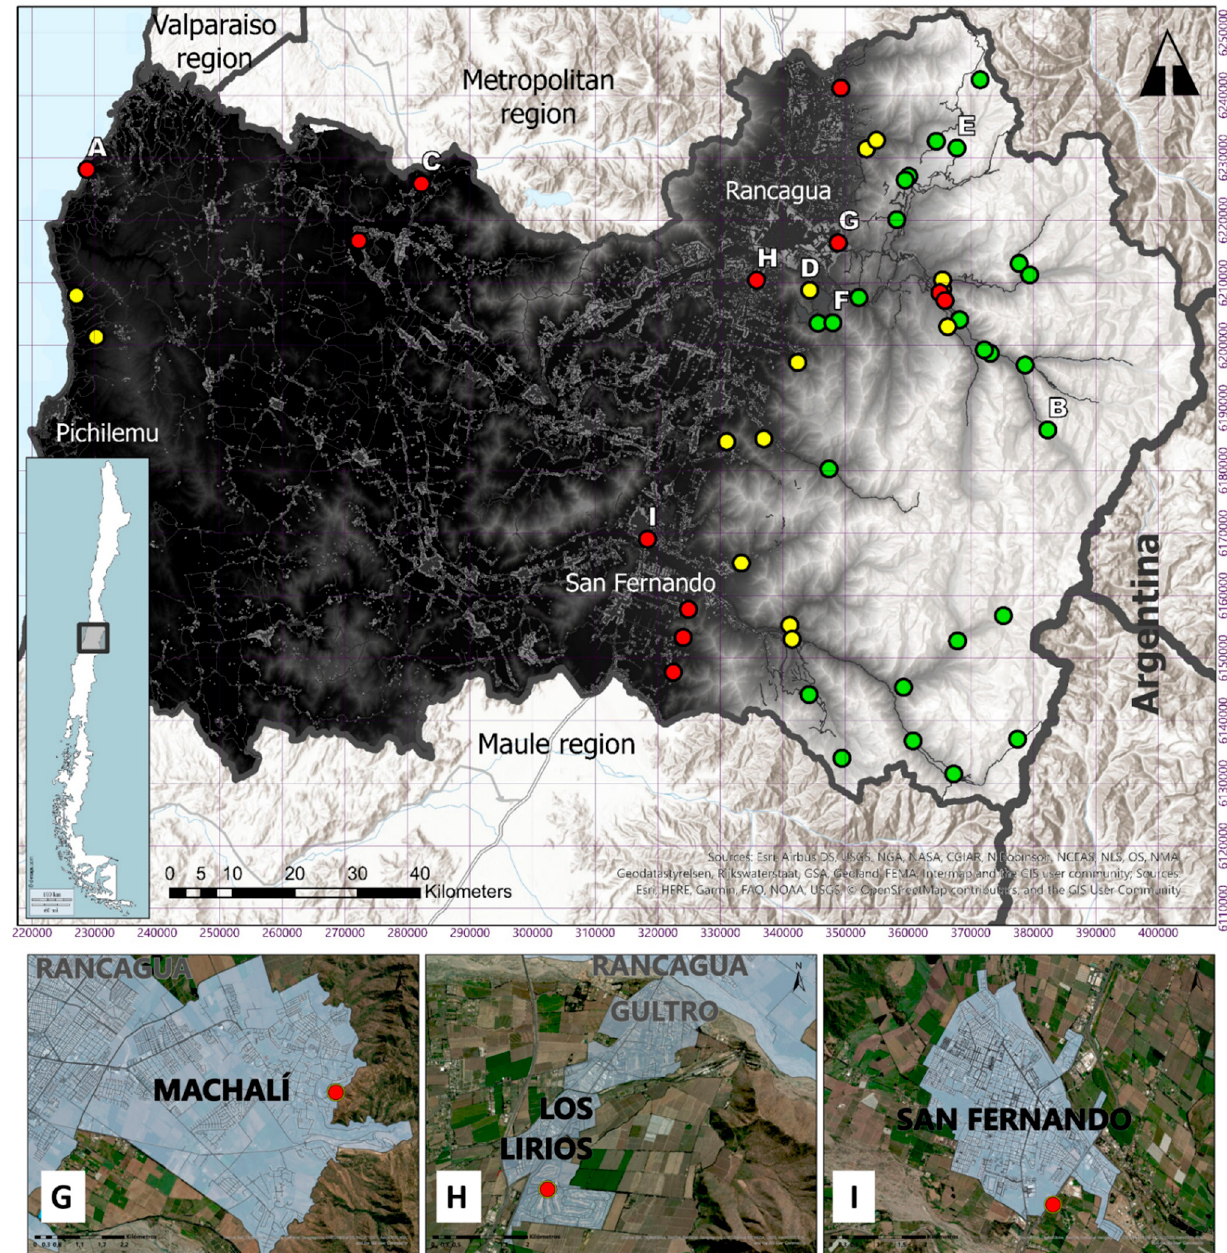
Figure 3. The geographic location of records of P. concolor in the O’Higgins region, central Chile. Color coding according to proximity to human settlement: Red circle—very close (0 to 999 m); Yellow circle—moderately close (1000 to 4999 m); Green circle—distant (>5000 m). Letters correspond to records from Figure 2 and three sites indicated at the bottom of the figure (G: Machalí, H: Los Lirios, I: San Fernando). Below: The three closest records within the urban limits of large cities in the O’Higgins region. Grey shadow: Urban area, darker grey = high demographic concentration, lighter grey = low demographic concentration.